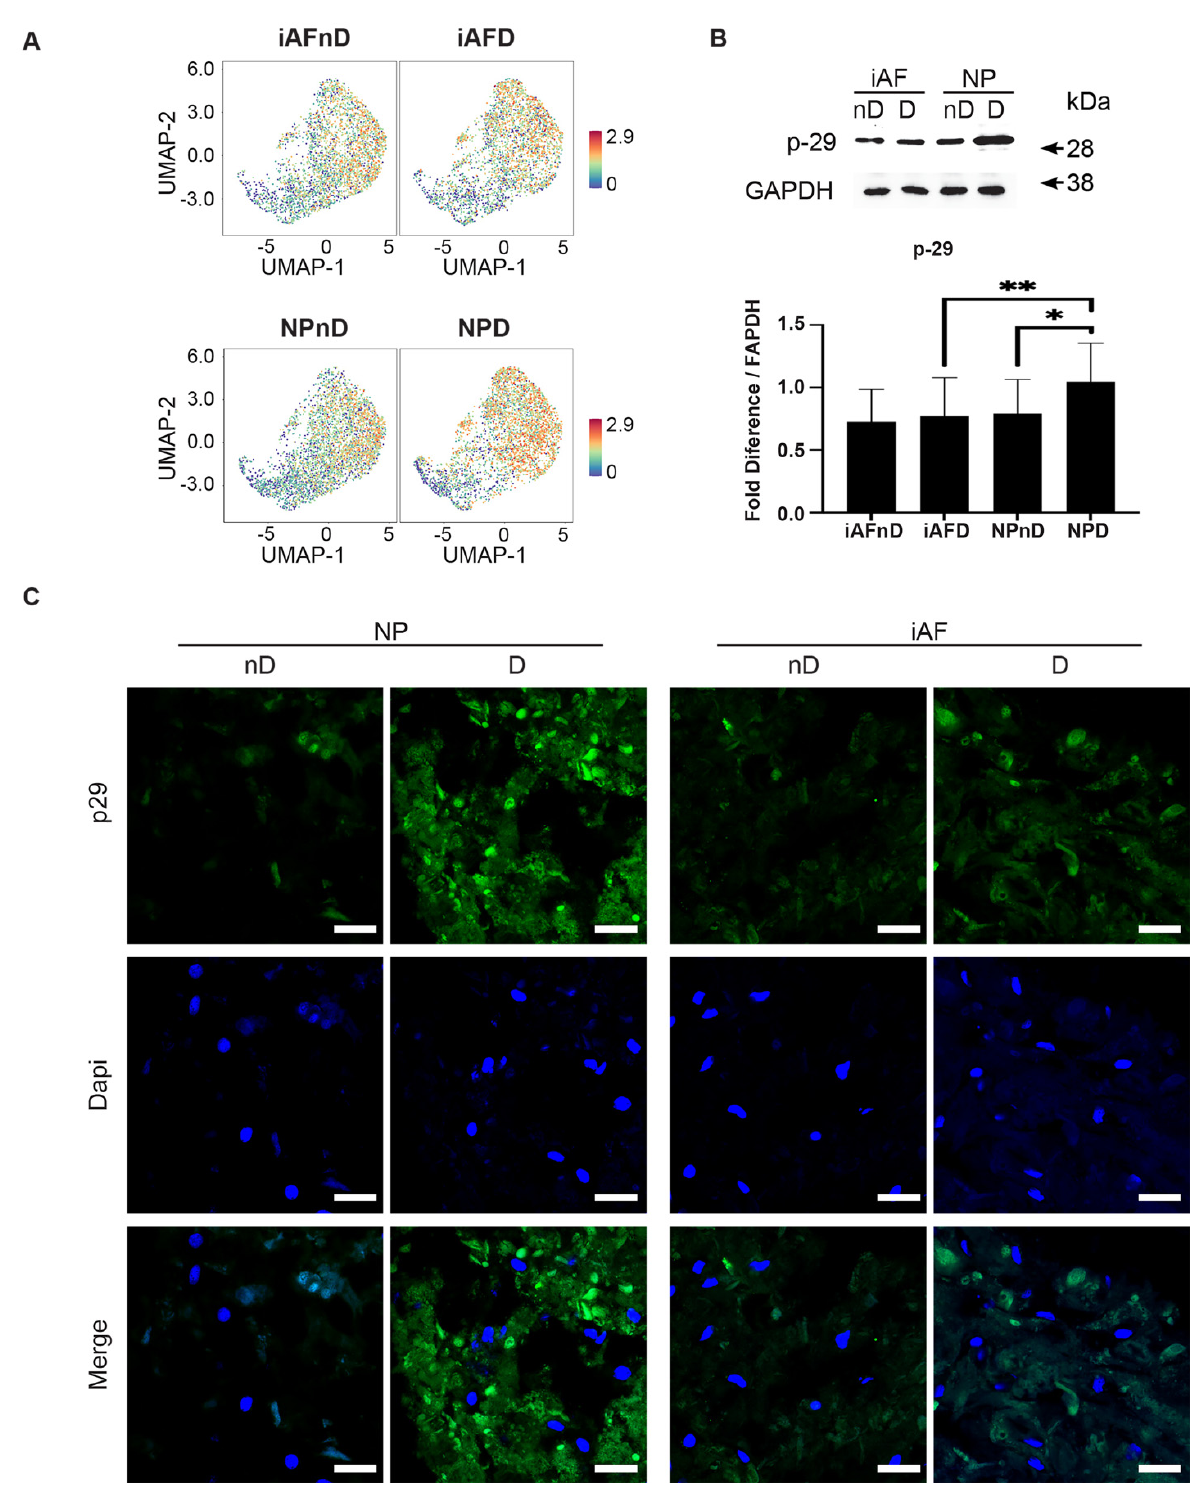
Figure 9. Validation of selected cell type and degeneration markers. ( A ) UMAP highlighting p29 gene expression at the single-cell level in iAF and NP nD and D discs of the same individual. ( B ) Western Blot analysis of cell lysates from 5 additional individuals normalized to GAPDH (n = 5). ( C ) Immunohistochemistry staining of p29 (in green), Dapi (in blue) and merged images of cells from 5 additional individuals (scale = 100 µm, n = 5 biological replicates). Graphs are presented as mean ± SEM. * p < 0.05, ** p < 0.01.